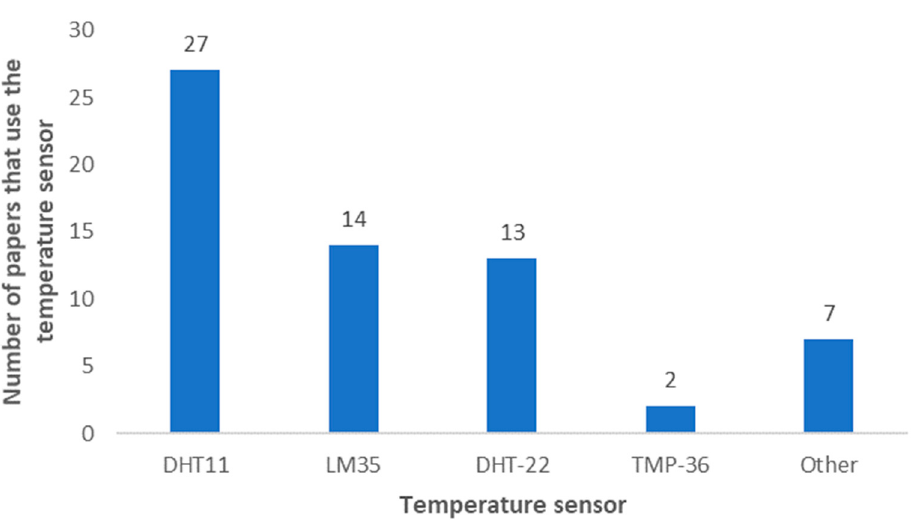
Figure 15. Most utilized temperature sensors. Table 2. Temperature monitoring sensors.